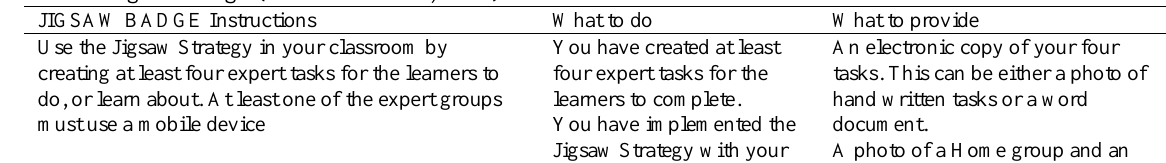
Table 4 Jigsaw Badge (Botha & Verster, 2014)